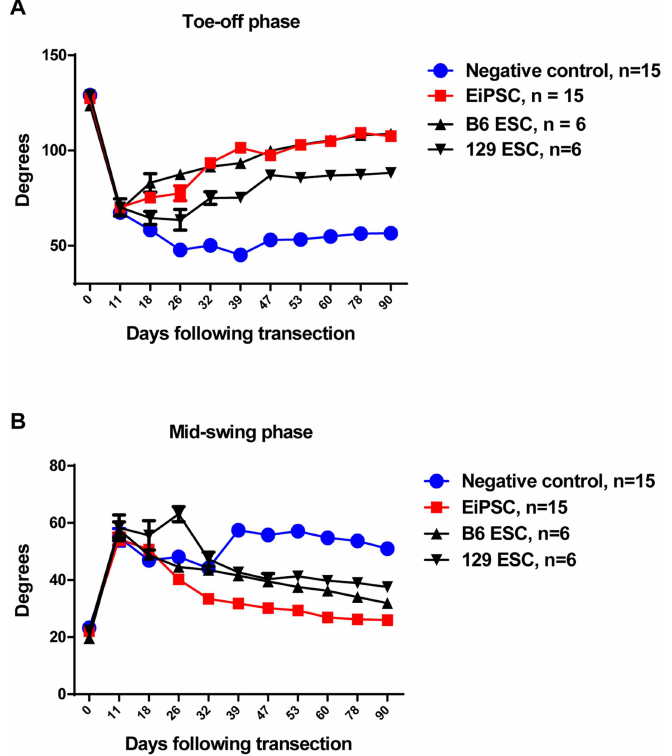
Fig 4. Functional recoveryevaluated using video gait analysis. (A) Ankle angles during the toe-off phase post sciatic nerve transection in four groups. The statistical data comparingEiPSC, 129 ESCs and B6 ESCs groups between negative control showed a mean ± SEMdifference which was significant ( P value of < 0.0001, one-way ANOVA). (B) Ankle angles during the mid-swingphase post sciatic nerve transection in four groups. The statistical data comparingEiPSC, 129 ESCs and B6 ESCs groups between negative control showed a mean ± SEMdifference which was significant ( P = 0.0063, one-way ANOVA).